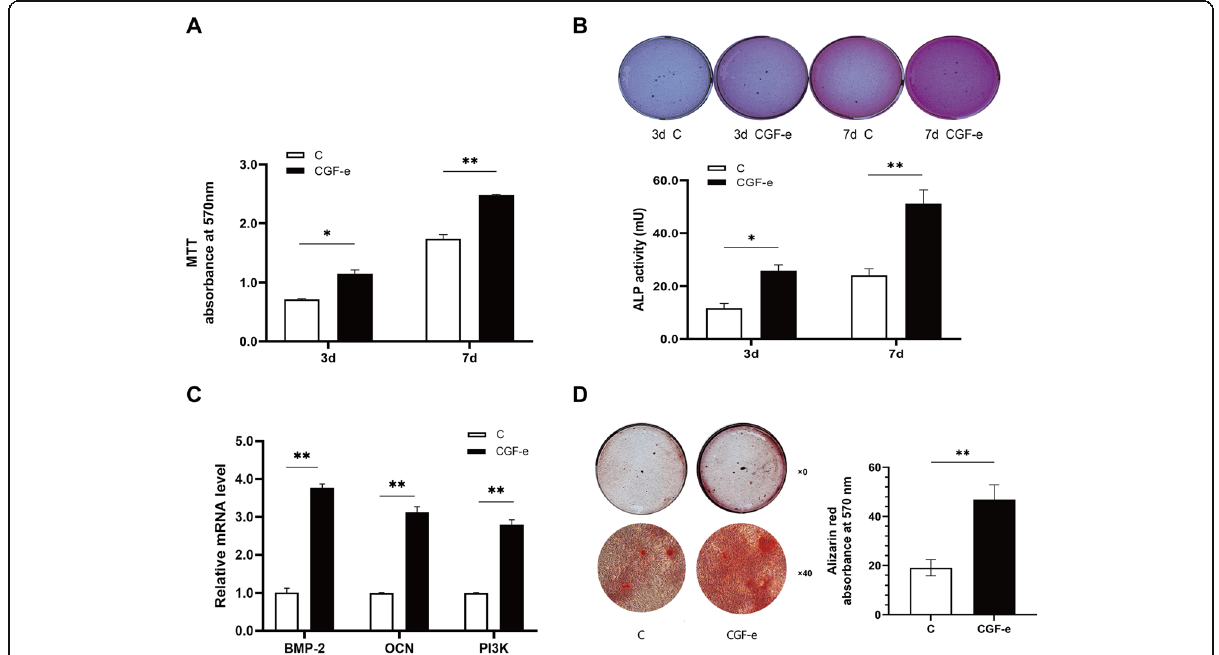
Fig. 2 Effects of CGF-e on osteoblast proliferation and differentiation. a Proliferation analysis of MC3T3-E1 cells, the optical density value of CGF-e group was significantly higher than control group at 3 days. b ALP staining and enzyme activity of MC3T3-E1 cells, the CGF-e group exhibited more ALP-stained spot than control. Pictures of the ALP staining plates were taken using a Canon 60d camera (no magnification). Similarly, the enzyme activity in the CGF-e group was significantly higher than control at 3 days. c Relative gene expression of MC3T3-E1 cells, the relative gene expression of the two genes was significantly higher in the CGF-e group compared with the control group (BMP-2, bone morphogenetic protein-2; OCN, osteocalcin; PI3K, phosphoinositide 3-kinase). d Mineralization analysis of MC3T3-E1 cells, the number of calcium nodules of the CGF-e group was more than the control group. Pictures of the Alizarin Red staining plates were taken using a Canon 60d camera (no magnification); the samples were then examined under a light microscope at ×40 magnification. Quantitative analyses showed that absorbance value of CGF-e group was higher than control. * p < 0.05; ** p <